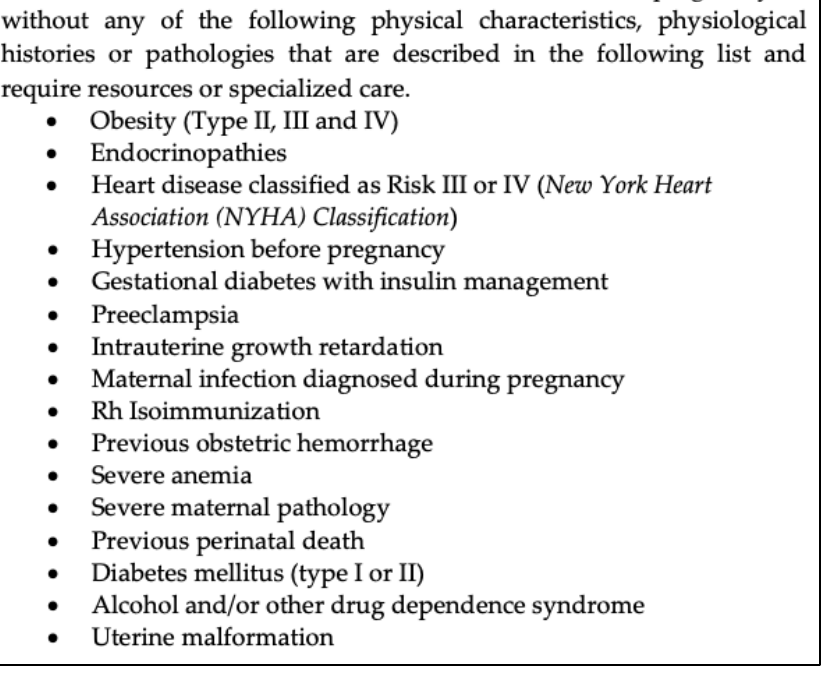
Figure 1. Low-risk classification.